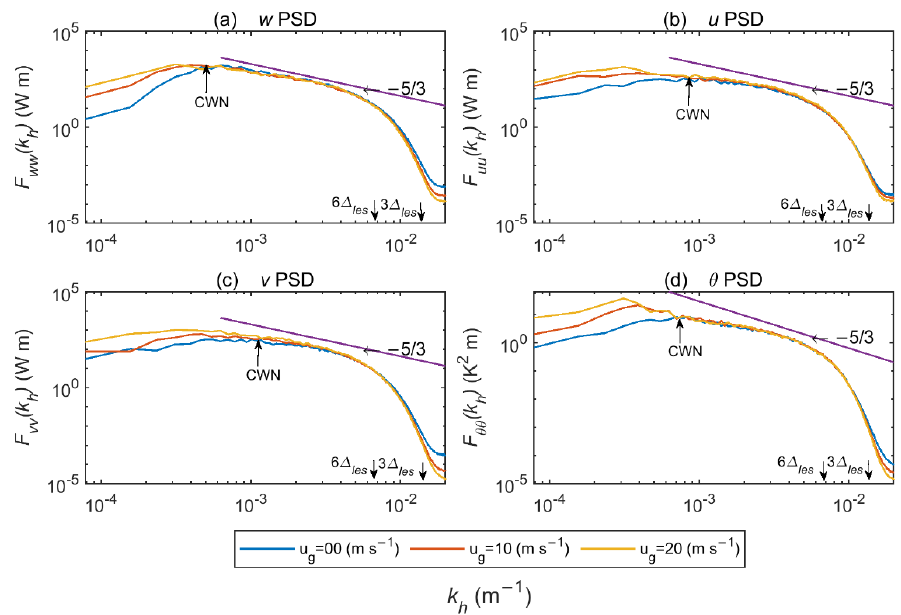
Figure 9. The instantaneous snapshots of w 1-d PSD 𝐹 𝑤𝑤 (𝑘 ℎ ) ( a ), u 1-d PSD 𝐹 𝑢𝑢 (𝑘 ℎ ) ( b ), v 1-d PSD 𝐹 𝑣𝑣 (𝑘 ℎ ) ( c ), and θ 1-d PSD 𝐹 𝜃𝜃 (𝑘 ℎ ) ( d ) from LES simulations at z / z i = 0.5 and 3 h of physical time with U g = 0 (blue line), 10(red line), and 20 ms −1 (yellow line). The x-coordinate represents the 𝑘 ℎ wavenumber ( 𝑘 ℎ = √𝑘 12 + 𝑘 22 ). y -coordinate represents the PSD value. The inclined straight lines have a slope of 𝑘 ℎ−5/3 .